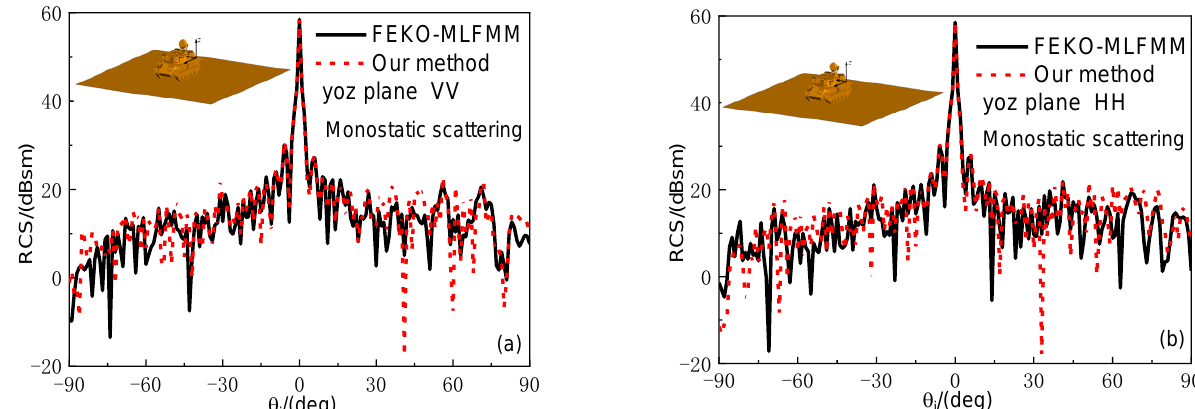
Figure 10. Monostatic scattering of ZSU-234 antiaircraft gun on the plane using our method and MLFMM: ( a ) monostatic VV; ( b ) monostatic HH. In Figure 11, the bistatic composite scattering of a cube on and above the rough ground is shown for different polarizations, where the incident frequency is f = 3 GHz and the incident angles are θ i = 30 and θ i = 50 , respectively. The size of the cube is 4 m × 4 m × 4 m, and the profile of the rough ground with a size of 32m × 32m is simulated by the Monte Carlo method [19]. The root mean square (RMS) height of the rough ground is l = 0.1 m, the correlation length is δ = 0.01 m, and the relative dielectric constant is ε r = ( 9.2, 1.2 ) . The scattering of the cube on rough ground is investigated in Figure 11a,c, and the scattering of the cube above rough ground is investigated in Figure 11b,d. Figure 11 presents four types of RCS, including the total scattering, target scattering, couple scattering and ground scattering. It can be observed that near the specular direction, the scattering of the rough ground is close to the total scattering. In addition, it can be also seen that near the backward direction, the coupling field is close to the total scattering. This is because a dihedral angle structure with strong reflectiveness is formed between the cube and rough ground. Therefore, the coupling scattering between the target and rough surface cannot be ignored.